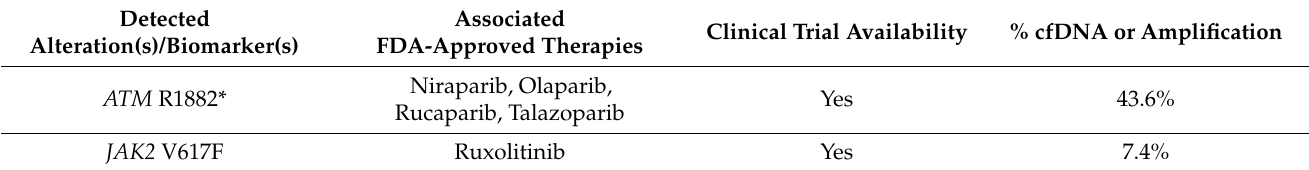
Table 2. Results of the genetic analysis testing of the patient’s blood performed through Guardant360 ® CDx testing.